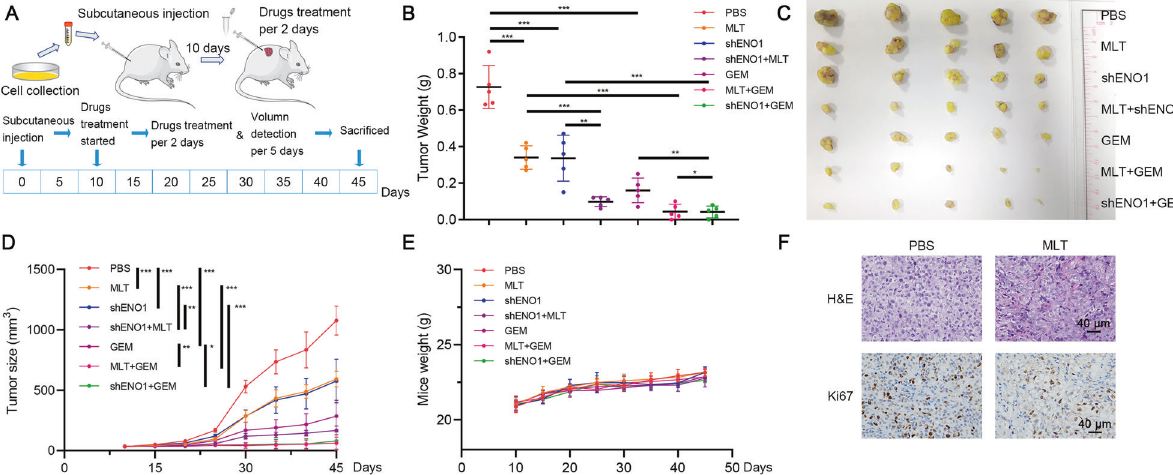
Fig. 5 Melatonin treatment or silencing of ENO1 could suppress BLCA growth in vivo. A Pattern of in vivo model construction and drug treatment. B Weight of xenograft tumors ( n = 5). C General view of dissected tumors. D Volume of xenograft tumors ( n = 5). E Measurement of mice weight. F Representative pictures of staining assays. Scale bar: 40 μ m. * p < 0.05, ** p < 0.01, *** p < Fig. S14D) [33, 34], while Rosiglitazone (a PPAR γ agonist) could increase the transcription level of ENO1 in melanoma cells (Supplementary Fig. S14E). Silencing of PPAR γ by transfecting speci fi c siRNAs caused the reduction of the protein level of ENO1 in BLCA cells (Supplementary Fig. S14F). Moreover, transfecting UM-UC3 cells with PPAR γ -Flag plasmid reversed the down- regulated ENO1 protein level under melatonin treatment (Fig. 6F). Treating BLCA cells with Rosiglitazone also effectively recovered the reduced mRNA level of ENO1 by melatonin treatment (Supplementary Fig. S14G). Dual-luciferase reporter assays showed that PPAR γ promoted the activity of wild-type ENO1 promoter plasmid (Fig. 6G, H). Both melatonin and GW9662 treatments inhibited the activity of ENO1 luciferase reporter (Supplementary Fig. S14H). ChIP-qPCR analysis showed that PPAR γ presented a strong binding activity on the ENO1 promoter (Fig. 6I).